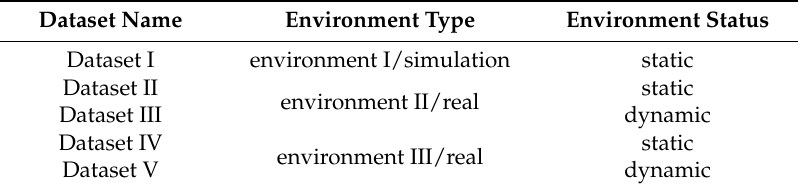
Table 1. The environment status and type for each experimental